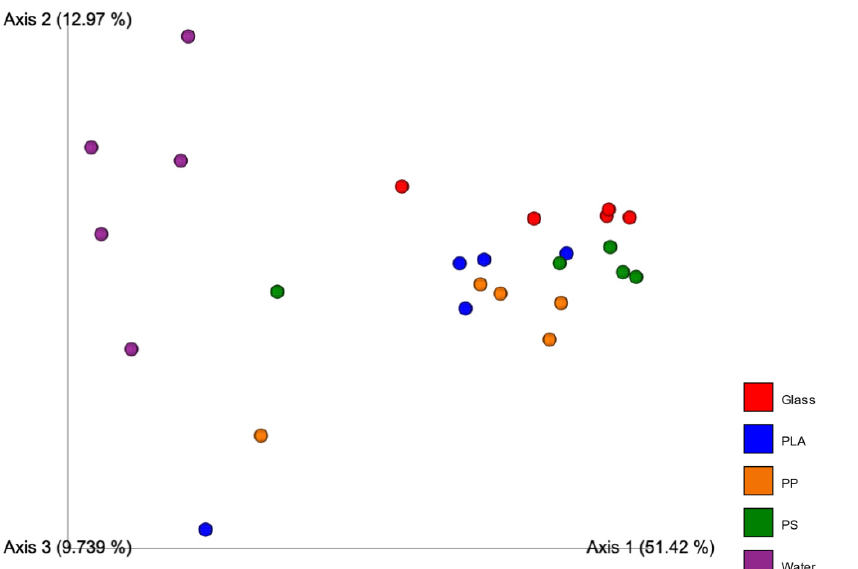
Figure 5. PCoA plots showing the dissimilarity of samples grouped by material they were extracted from. Beta diversity measures show the weighted unifrac